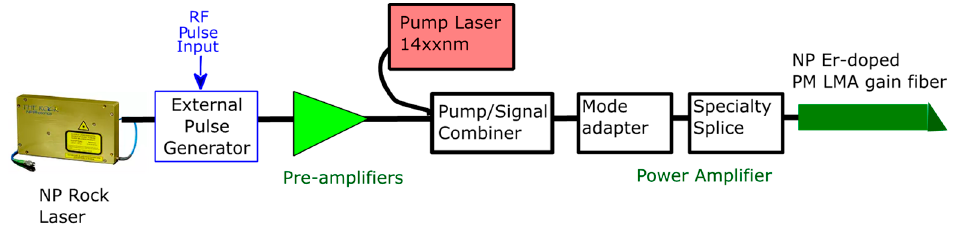
Figure 1. Eye-safe SBS-free coherent fiber laser architecture.